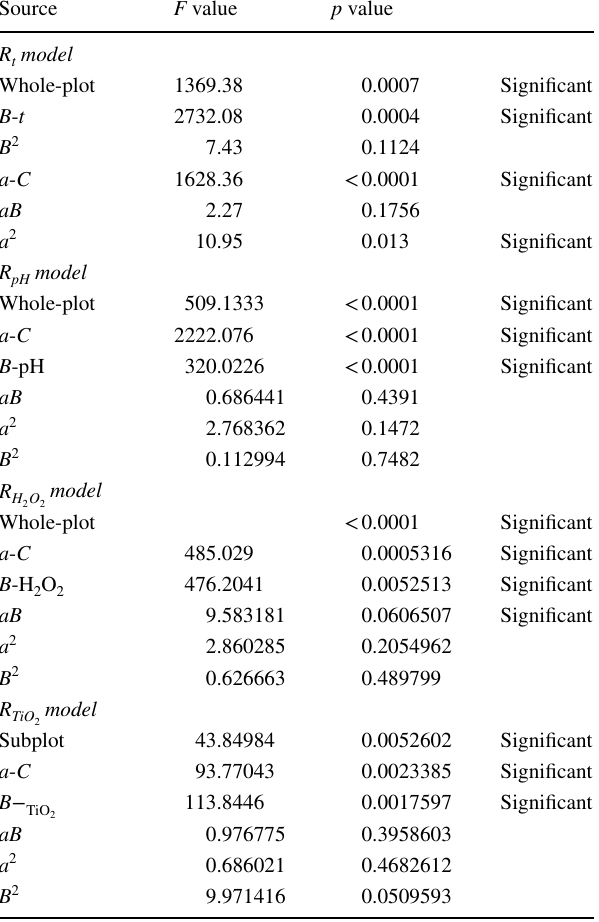
Table 6 Restricted maximum likelihood (REML) analysis for the developed RSM models